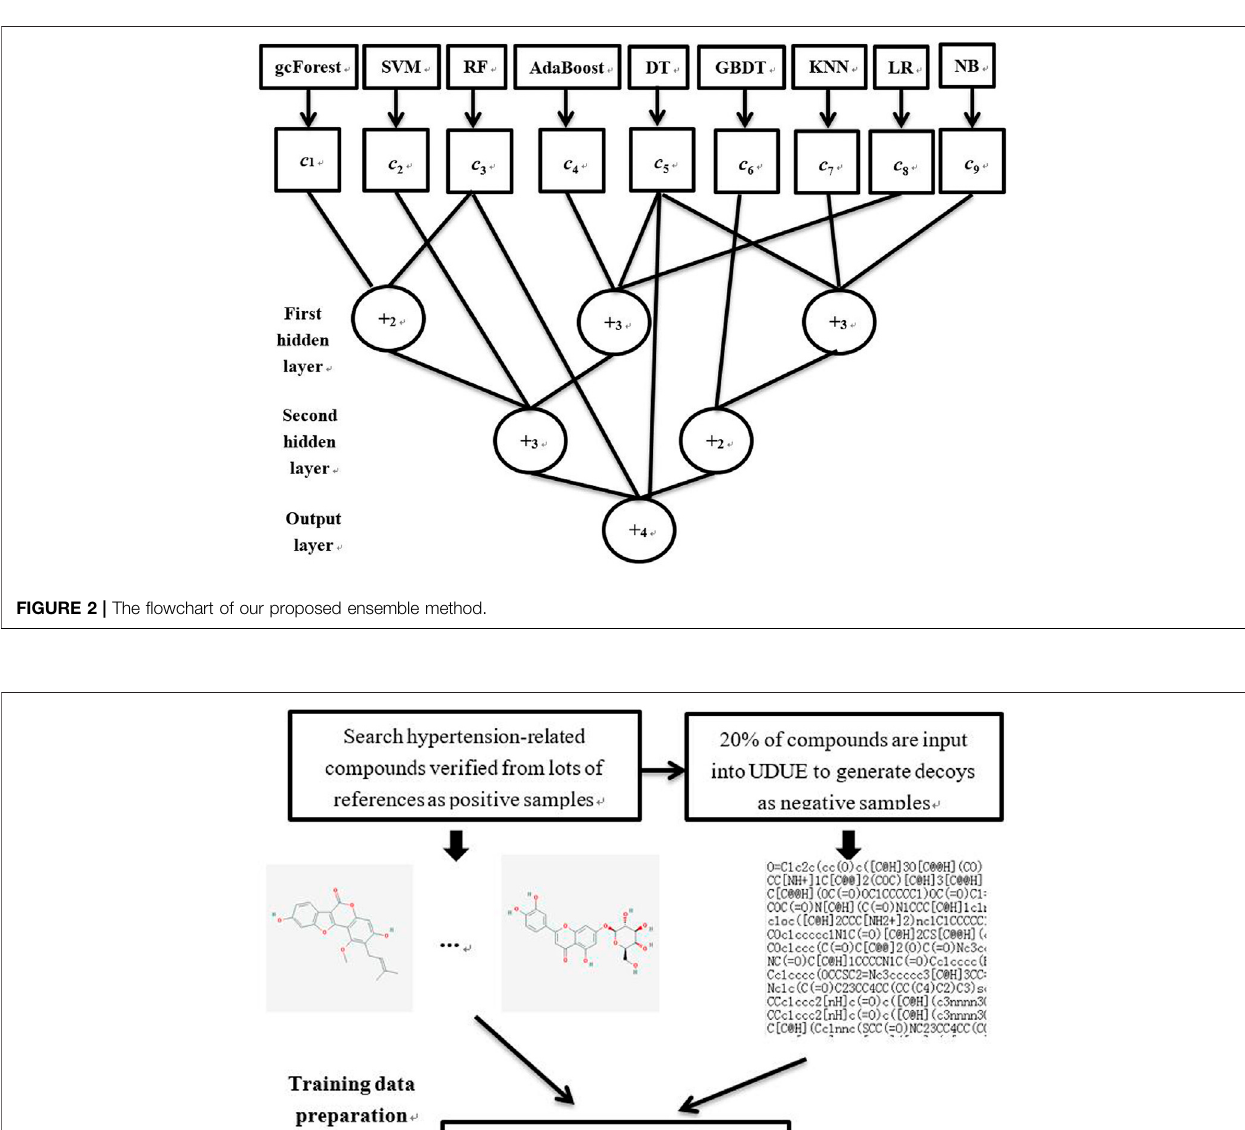
Frontiers in Genetics |